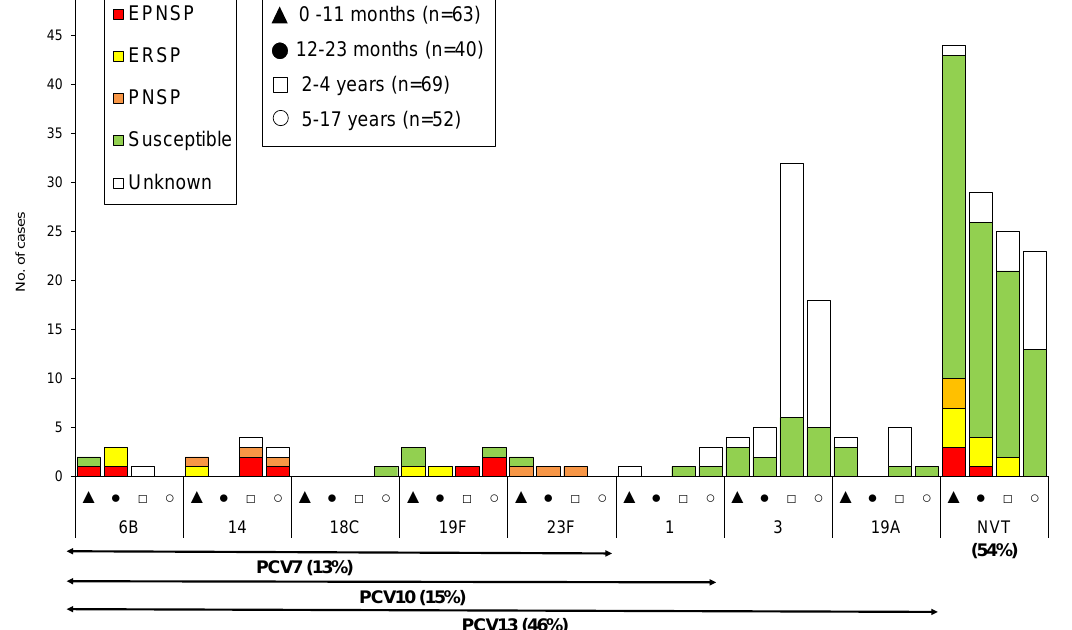
Figure 1. Number of samples representing serotypes present in conjugate vaccines causing invasive infections in Portugal (2015–2016 to 2017–2018). The number of samples representing each serotype in each of the age groups considered is indicated. Isolates presenting both erythromycin resistance and penicillin nonsusceptibility (EPNSP) are represented by red bars. Penicillin non-susceptible isolates (PNSP) are indicated by orange bars. Erythromycin-resistant isolates (ERSP) are indicated by yellow bars. Isolates susceptible to both penicillin and erythromycin are represented by green bars. Where pneumococci were detected exclusively by PCR or where the isolate was lost before antimicrobial susceptibility testing and for which susceptibility is unknown, are indicated by white bars. The serotypes included in each of the conjugate vaccines are indicated by the arrows. NVT—non-vaccine serotypes, i.e., serotypes not included in any of the currently available conjugate vaccines (PCV7, PCV10 and PCV13). The values indicated below the arrows are the proportion of each group in the overall cases ( n = 223). Serotypes 4, 5, 7F, 9V, 18C included in PCV13, PCV10 or PCV7 were not detected in the study